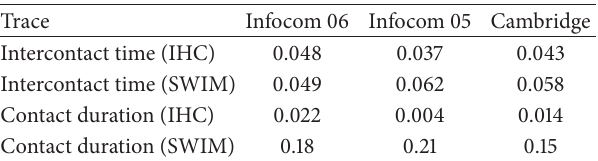
Table 4: Jensen-Shannon divergence between distributions of the real and IHC traces, comparing with the corresponding results of SWIM traces.